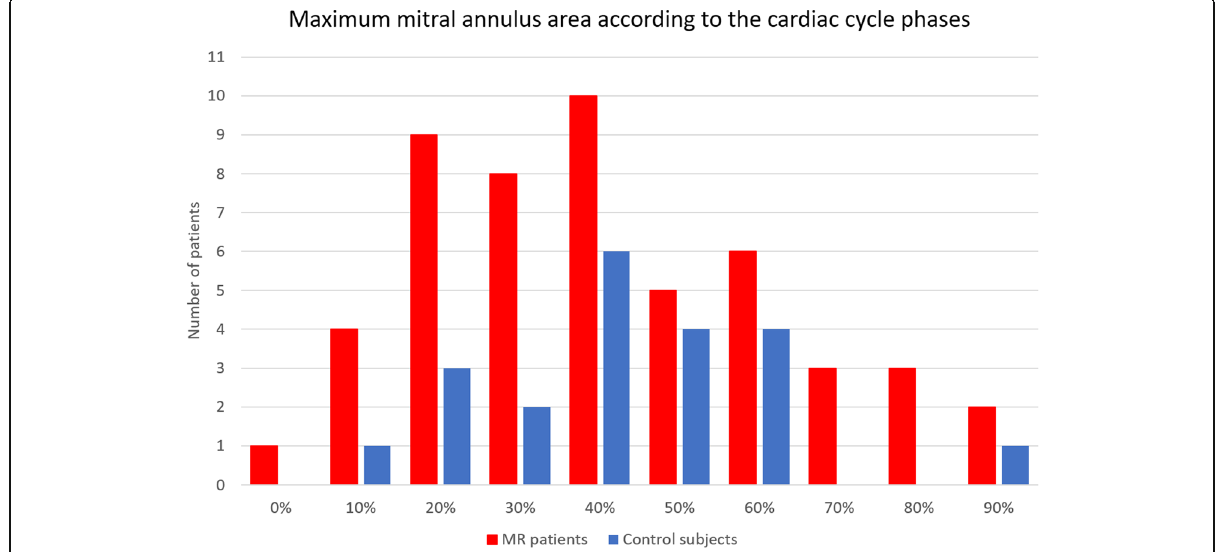
Fig. 7 Distribution of maximum mitral annular area in mitral regurgitation and control